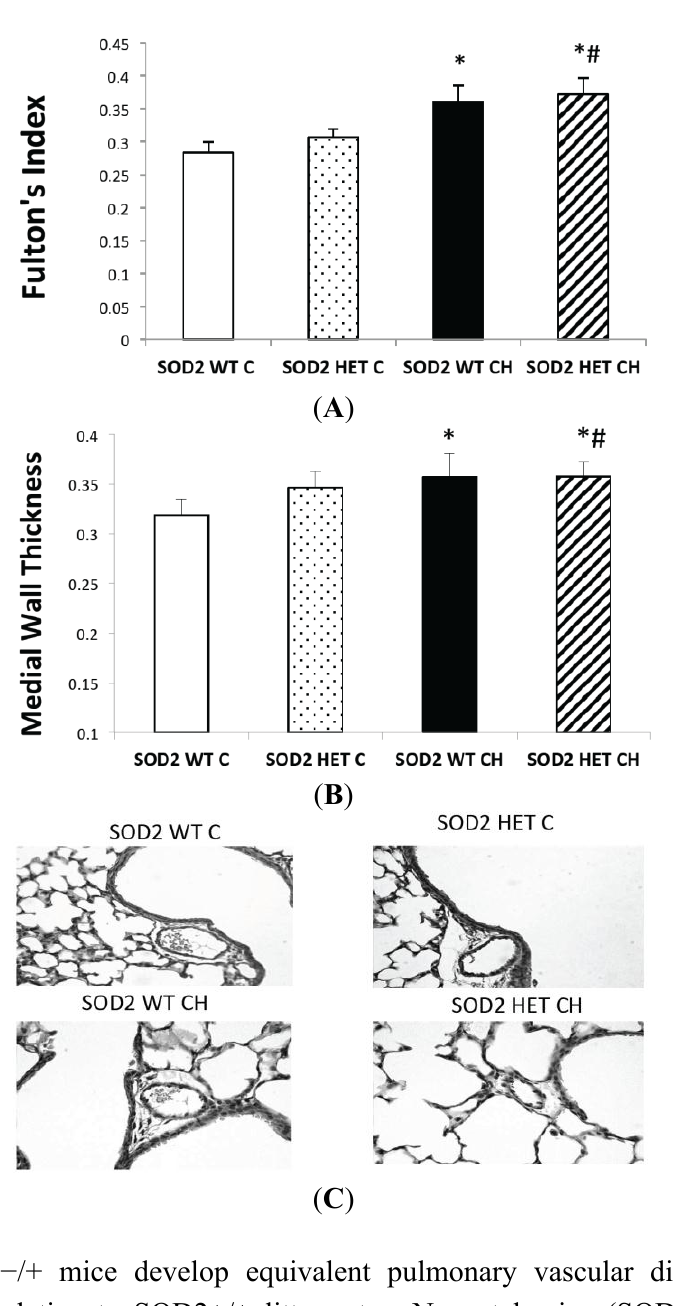
Figure 5. SOD2−/+ mice develop equivalent pulmonary vascular disease in chronic hyperoxia (CH) relative to SOD2+/+ littermates. Neonatal mice (SOD2−/+ (HET) and isogenic SOD2+/+ (WT) littermates) were exposed to chronic hyperoxia (CH) or room air (Control (C)) from birth to 14 days of life. Mice were euthanized on day 14, lungs were inflation fixed, and hearts were dissected. ( A ) Right ventricular hypertrophy was measured by Fulton’s index (right ventricle (RV) weight/left ventricle plus septum (LV + S) weight) and compared with age-matched control mice ( n = 20 per group; * p < 0.05 vs. SOD2 WT Control mice, # p < 0.05 vs. SOD2 HET Control mice). Data are shown as mean ± SEM; ( B ) Vascular remodeling was measured by medical wall thickness (MWT). Data are shown as mean ± SEM ( n = 6–8 vessels per mouse with mice n = 6 (SOD2 WT C), 9 (SOD2 HET C), 4 (SOD2 WT CH), and 11 (SOD2 HET CH); * p < 0.05 vs. SOD2 WT Control mice, # p < 0.05 vs. SOD2 HET Control mice); and ( C ) Representative HE-stained lung sections (40×) for control (WT and HET) and CH (WT and HET)